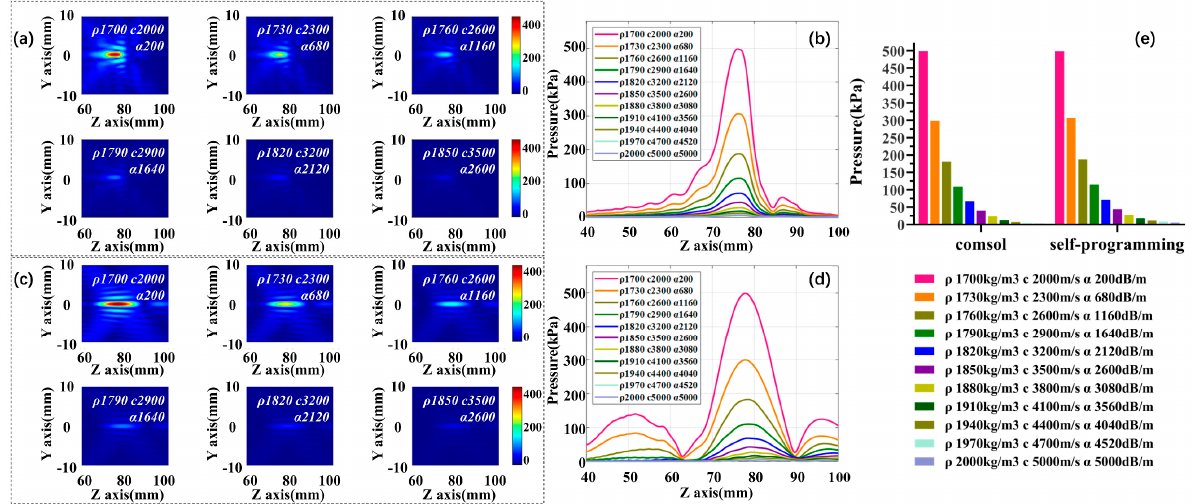
Figure 7. The effect of three factors varied simultaneously on focus acoustic pressure. ( a ) Self-programming focus acoustic pressure field; ( b ) self-programming acoustic axis acoustic pressure curve; ( c ) COMSOL focus acoustic pressure field; ( d ) COMSOL acoustic axis acoustic pressure curve; ( e ) histogram of focus acoustic pressure variation for both simulations.